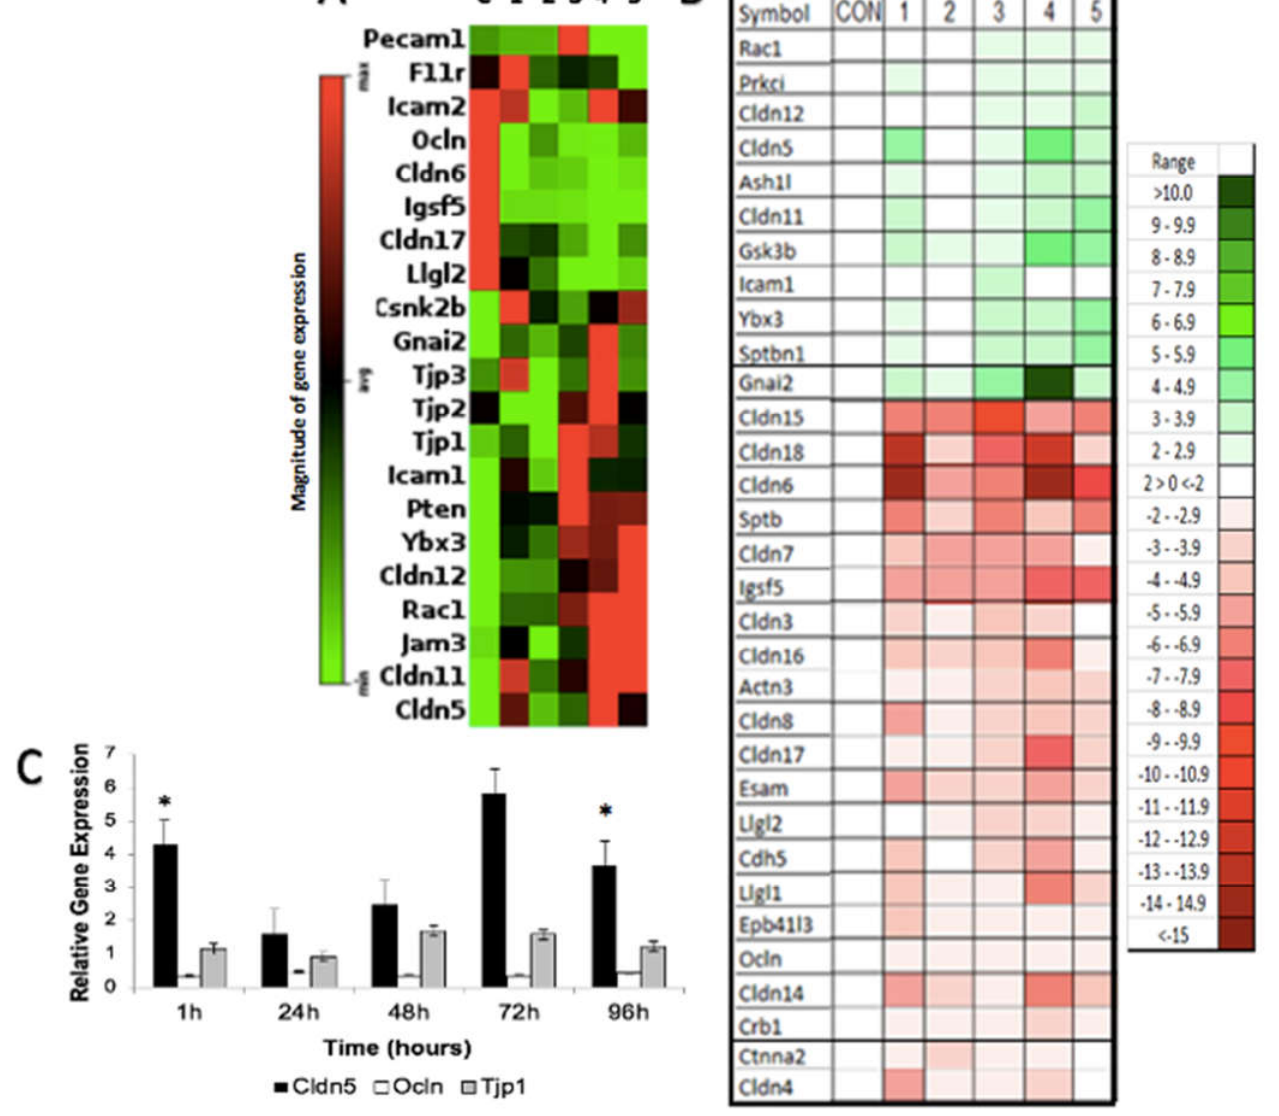
Figure 4. Heat maps of tight junction genes with significant changes in expression ( p < 0.05) following intracranial H-FIRE generated by GeneGlobe ( A )(magnitude of gene expression relative to overall average) and Ingenuity Pathway Analysis (IPA) software ( B )(z-score relative to sham control). C/CON = sham control , Group 1 = 1 h, Group 2 = 24 h, Group 3 = 48 h, Group 4 = 72 h, Group 5 = 96 h post-H-FIRE. Cldn5 (claudin-5) mRNA expression was significantly increased 1 h after intracranial H-FIRE delivery relative to sham controls, but expression was similar to sham controls by 24 h post-treatment then gradually increased over time. The magnitude of change in Tjp1 (zonula occludens-1) and Ocln (occludin) expression was not significant; however, Ocln expression was decreased relative to sham controls at all time points ( C ). * p < 0.05.